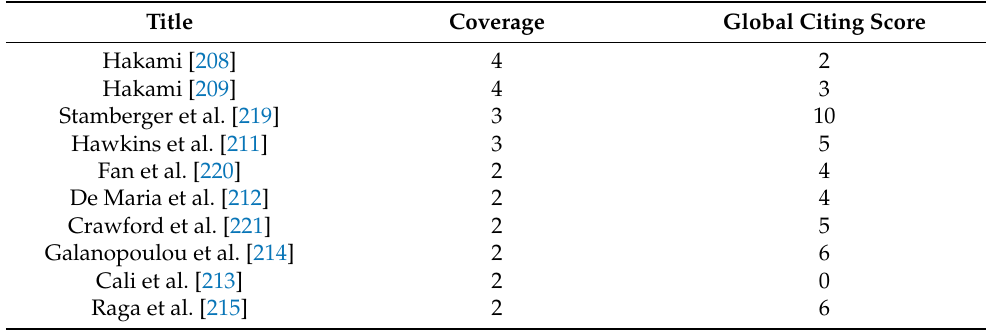
Table 14. Top 10 citing papers in Cluster #14 identified using